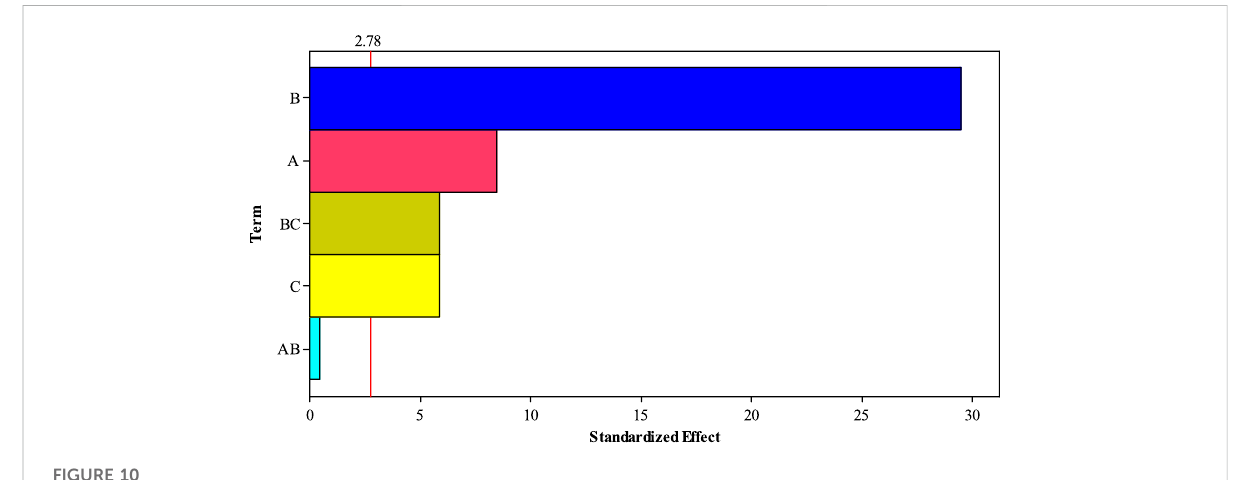
FIGURE 10 Pareto chart for different conditions of a 2 k − 1 design in H 2 S gas